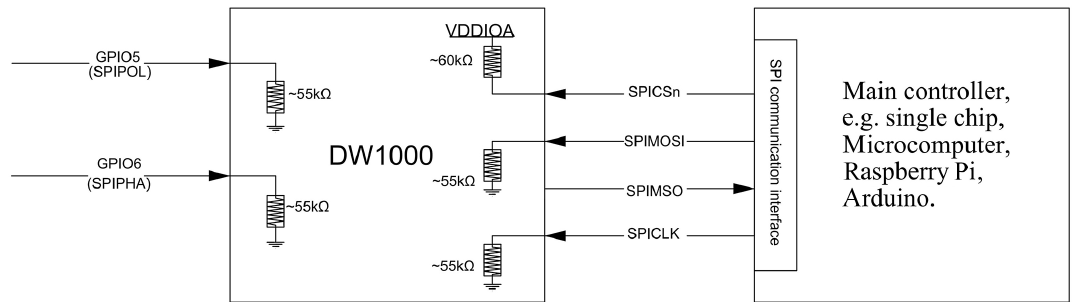
Figure 4. Circuit connection diagram of DWM1000 module.